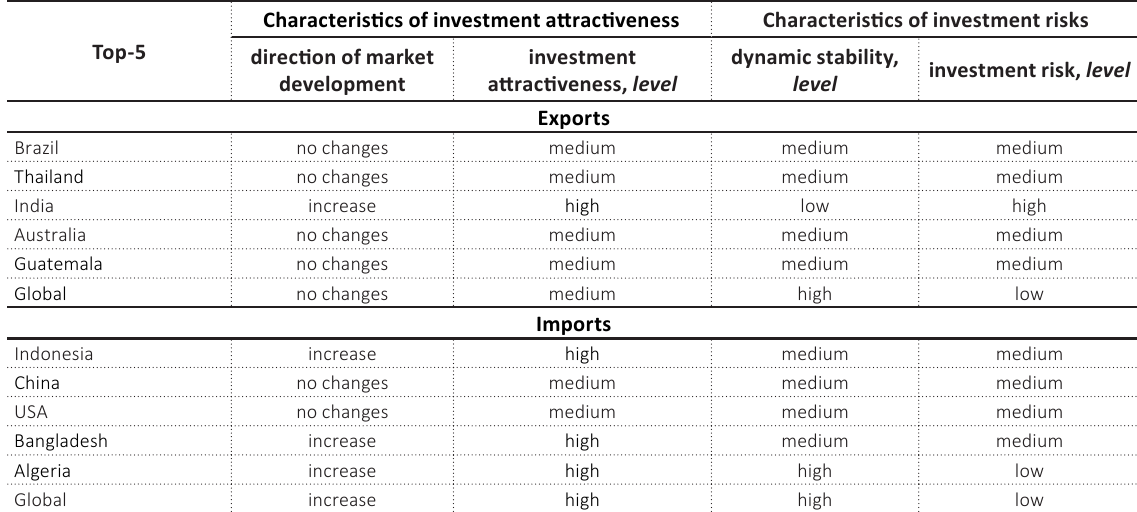
Table 6 (cont.). Investment attractiveness and risks of investing in the global sugar